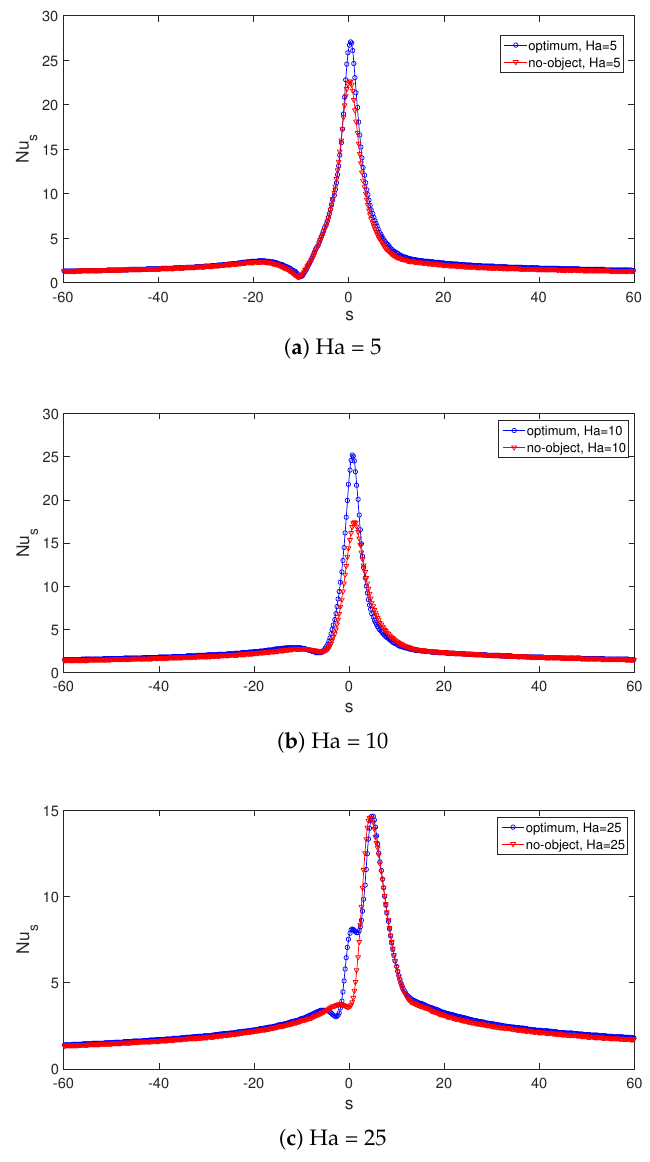
Figure 16. Comparison of local Nu variations at optimal flow conditions and in the no-object case (Da = 5 × 10 − 2 ) considering three different MaF strength